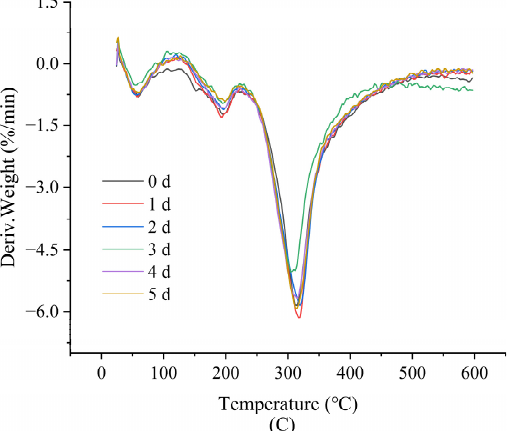
Figure 6. The DSC curves (A), TGA weight loss curves (B), and derivative weigh loss curves (C) of gelatin/zein/glucose nanofibers after Maillard reactions at 60 °C and relative humidity of 50% for 1~5 days. Table 2. The DSC and TGA data of gelatin/zein/glucose nanofibers after Maillard reactions con- ducted at 60 °C and 50% RH for 0~5 days. DSC